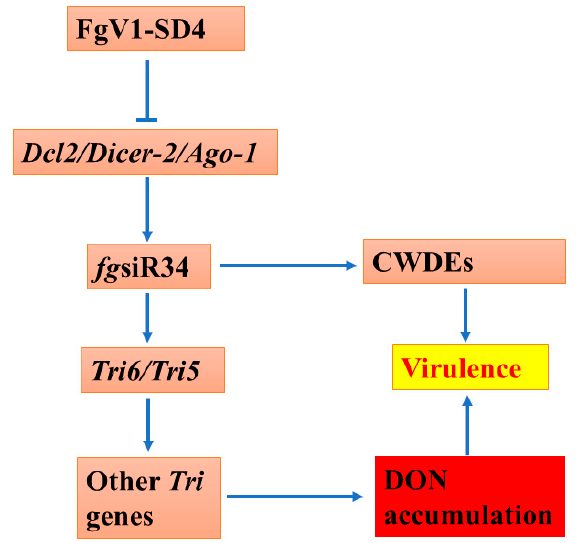
Figure 7. Proposed model of DON regulation in F. graminearum by FgV1 infection. The expression of fg siR34 in F. graminearum is indirectly suppressed by FgV1-SD4 through suppression of Ago1/Dicer-2/dcl2 by the virus. This ultimately results in decreased biosynthesis of DON through downregulation of Tri genes in FHB as fg siR34 regulates the expression of Tri6/Tri5 genes. fg siR34 also regulates expression of cell wall degrading enzymes (CWDEs) impacting the virulence of the